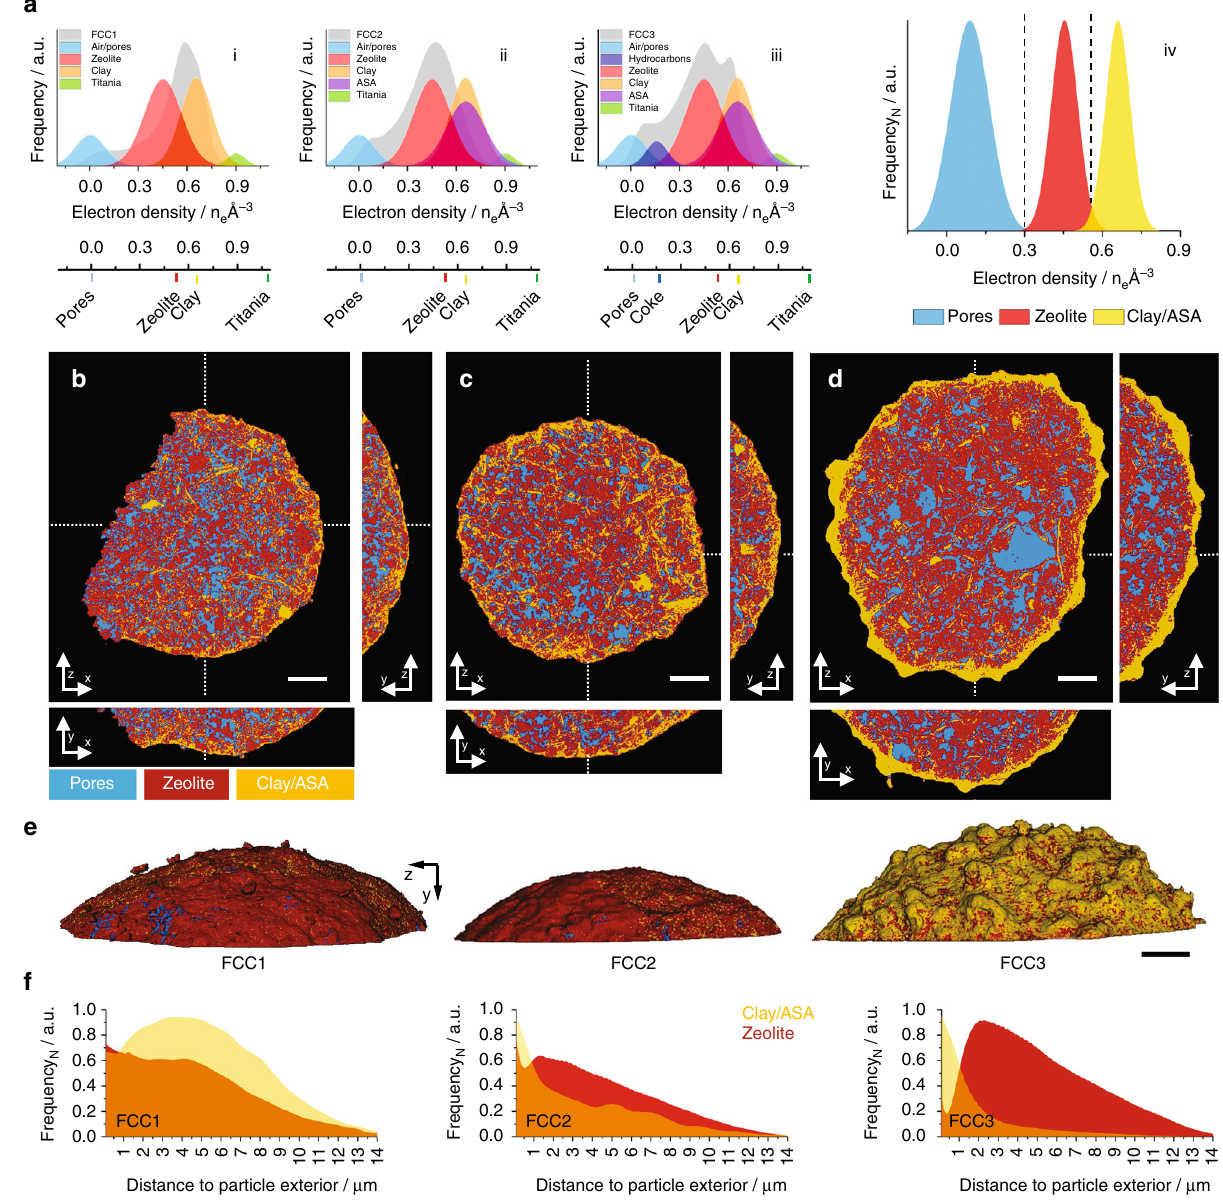
Fig. 3 Image segmentation of FCC1, FCC2, and FCC3. Shown in a are electron density histograms of FCC1 (i), FCC2 (ii), and FCC3 (iii) in their entirety alongside histograms of individual visually pure composite components extracted from FCC3 and calculated electron densities of known catalyst components. Isolated areas with edge lengths of ~250 – 300 nm taken from single voxel thick slices were chosen for the construction of composite component histograms. This was done to provide an indication of the full electron density spread of a component (i – iii). Shown in (iv) are normalized electron density histograms of the three elementary constituents of a FCC particle, pores, zeolite, and Clay/ASA, created by assigning selected components to one of these constituents. Air and hydrocarbons are grouped as pores ( blue ). Clay, ASA, and titania (TiO 2 ) combined to Clay/ASA ( orange ). Zeolites are shown in red . These histograms were obtained from volumes of (250 – 300 nm) 3 . Image segmentation of FCC1, FCC2, and FCC3 was initialized using the electron density intersections ( --- ) shown as dashed lines in (iv). Resulting segmented tomograms of FCC1, FCC2, and FCC3 are presented in b – d , respectively. Presented are bottom up ( z – x ) and orthogonal views ( y – z , y – x ). Cutting planes are represented by dotted lines . e Segmented volume renderings of the exterior of FCC1, FCC2, and FCC3. Scale bars are 5 µ m. See Supplementary Methods for further information on fi nite-resolution effects on such tomogram segmentation. Presented in f are distance maps of Clay/ASA and zeolite elements with respect to the particle